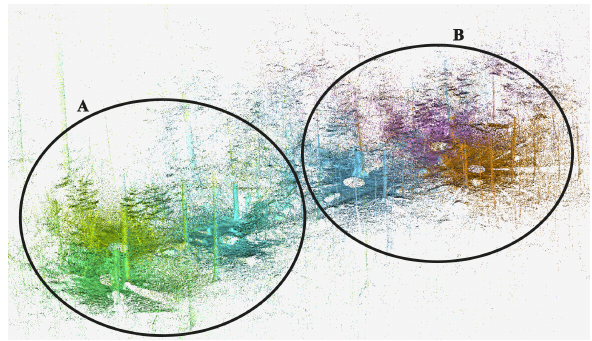
Figure 7: Forest data set with six scans divided into two triples A and B . Only 1% of the data is displayed.